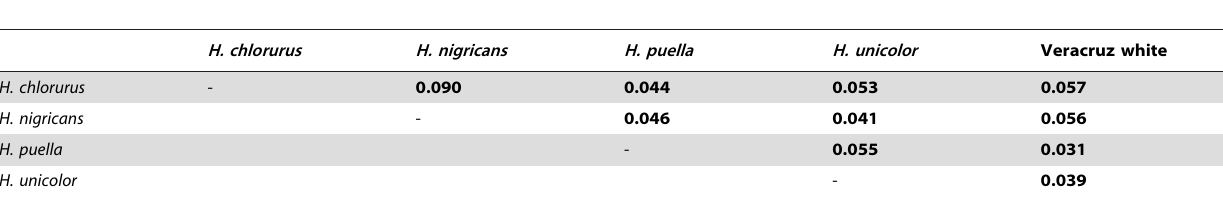
Table 2. Mean F ST values from AFLP data for pair-wise comparisons of Hypoplectrus global morphotypes (i.e. all individuals of a given morph collected across all